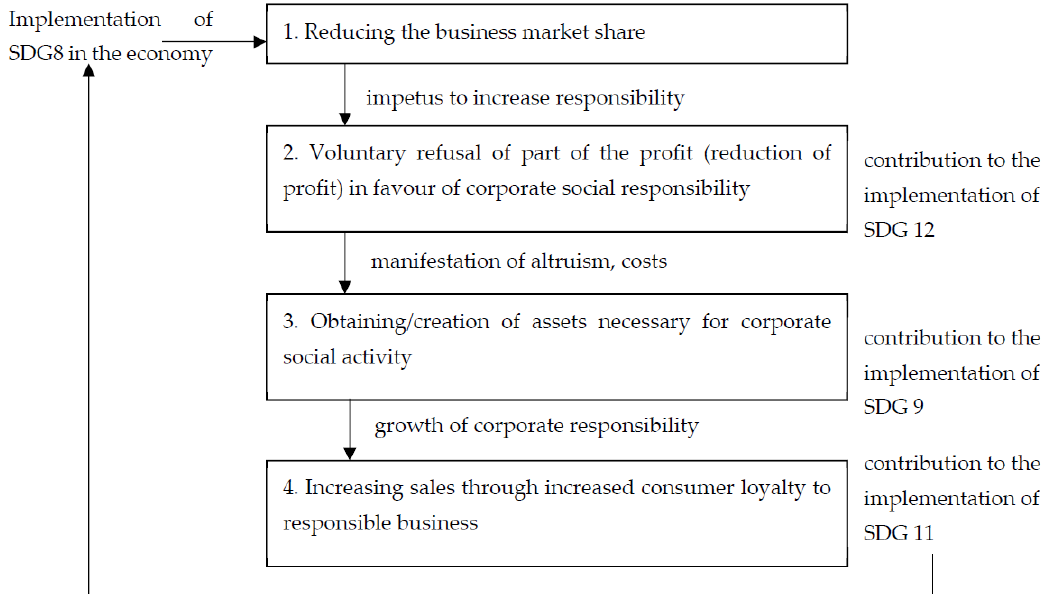
Figure 5. Systemic relationship between corporate social responsibility and financial risks of the business in terms of sustainable development. Source: developed and compiled by the authors.